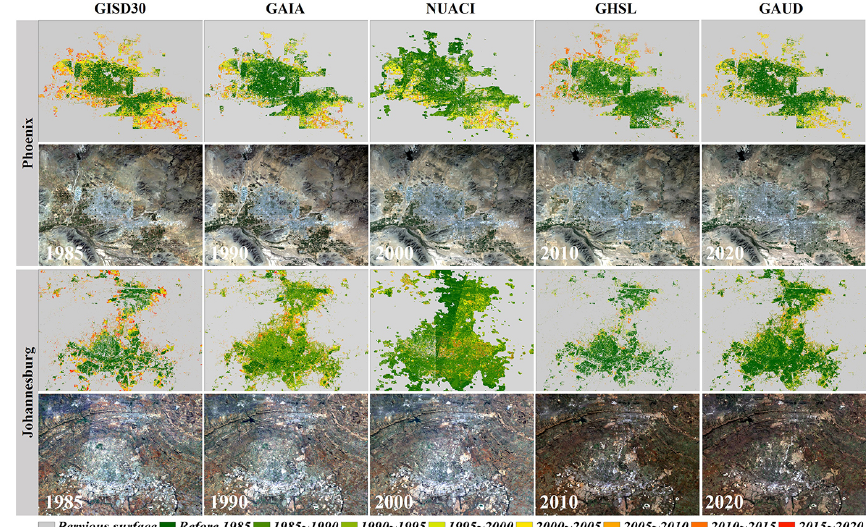
Figure 14. The comparisons between GISD30 and four reference datasets (the GAIA products developed by Gong et al., 2020; NUACI developed by Liu et al., 2018; GHSL developed by Florczyk et al., 2019; and GAUD developed by X. Liu et al., 2020) in the two representative arid cities of Phoenix and Johannesburg. In each case, the multi-epoch Landsat imagery, comprised of red, green and blue bands, came from the United States Geological Survey